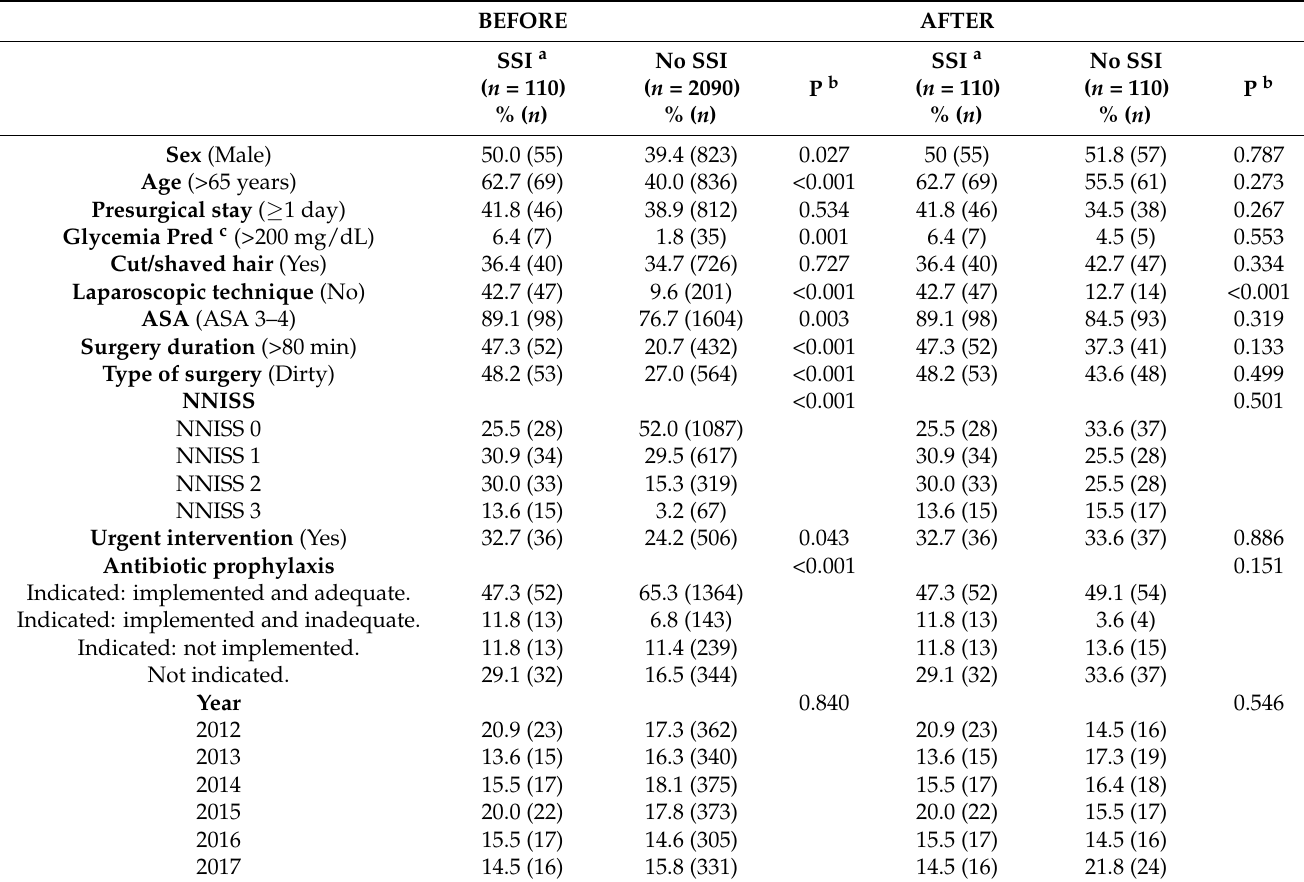
Table 2. Patient characteristics before and after matching using the propensity